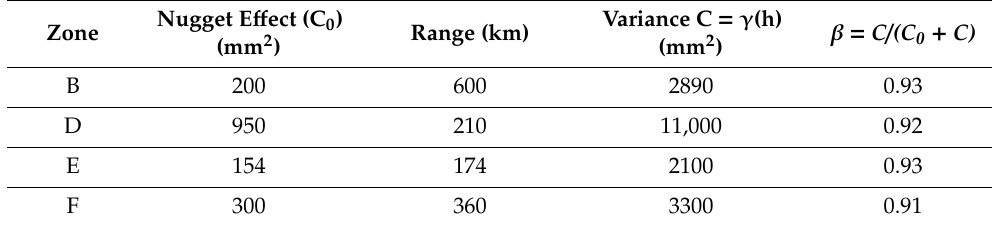
Table 2. Parameters of the variograms of the zones B, D, E, and F, at the regional